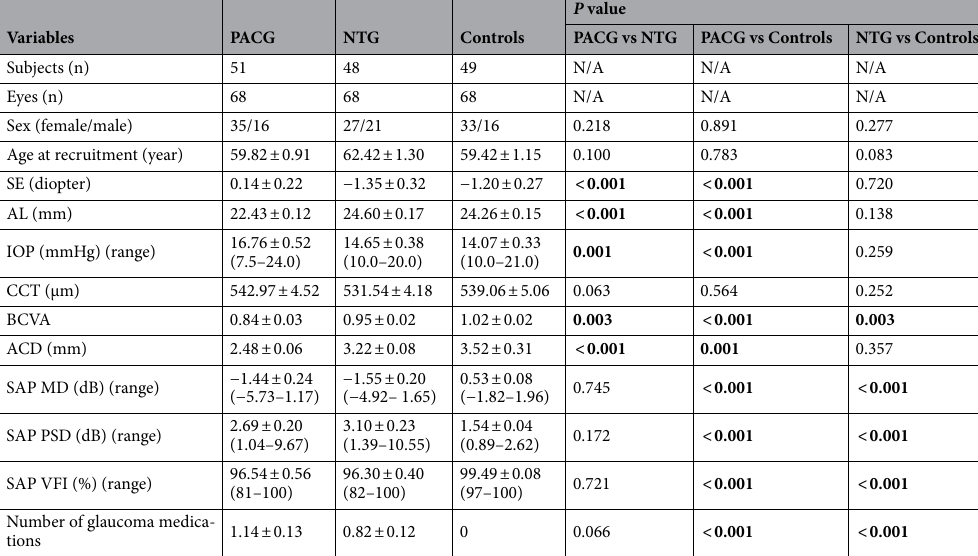
Table 1. Demographics and ocular characteristics among PACG, NTG, and Controls. Significant values are in bold. CCT = central corneal thickness; BCVA = best-corrected visual acuity; ACD = anterior chamber depth; SE = spherical equivalent; AL = axial length; IOP = intraocular pressure; SAP = standard automated perimetry; MD = mean deviation; PSD = pattern standard deviation; VFI = visual field index; PACG = primary angle closure glaucoma; NTG = normal tension glaucoma. *Statistical significance was tested by generalized estimating equation (for continuous variables) or chi-square test (for categorical